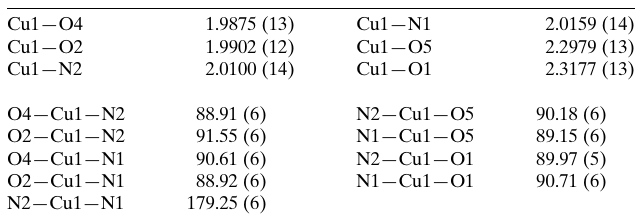
Table 1 Selected geometric parameters (A˚ , (cid:4) ).